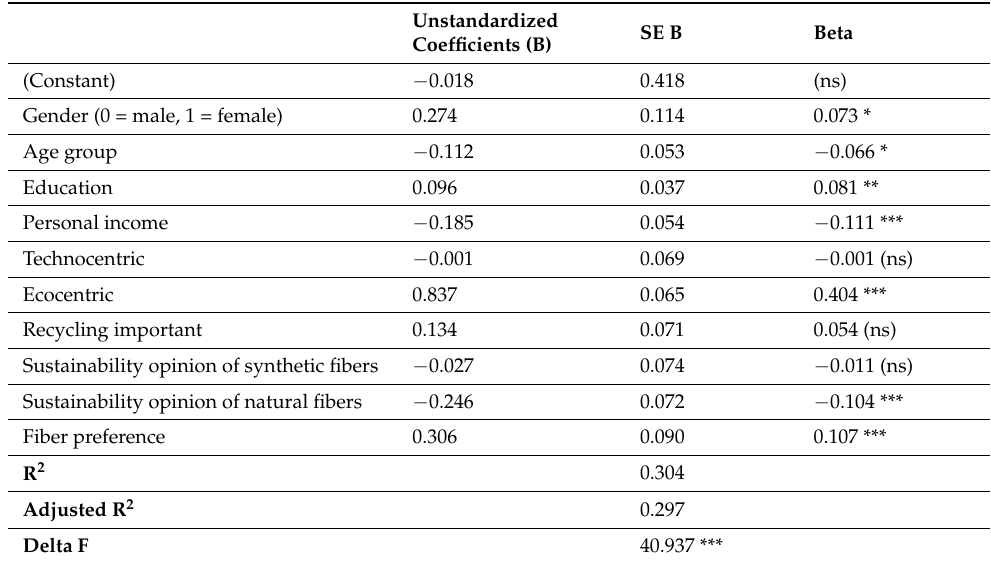
Table 6. Regression model 2 for reduced clothing consumption. (SE B = standard error for B. * p <